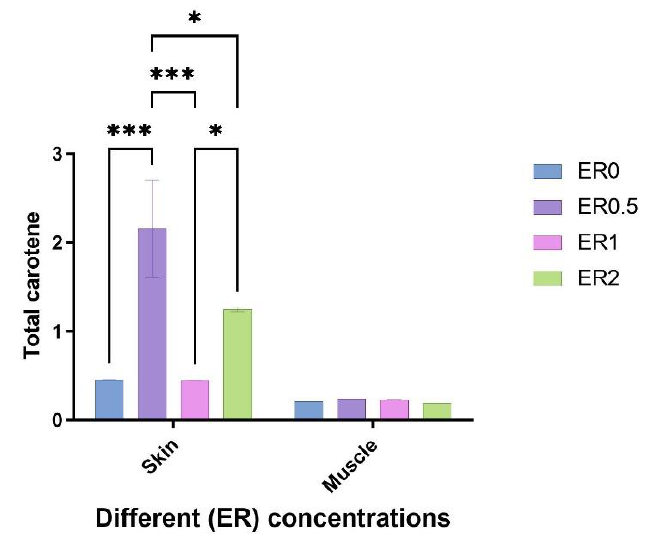
Figure 4. Total carotene in skin and muscle of Red tilapia fed on different experimental diets. Values are expressed as mean ± SE from triplicate groups. p values of one-way ANOVA followed by Tukey’s post hoc test for significant differences. p < 0.05 (*), and p < 0.001 (***), between different groups.